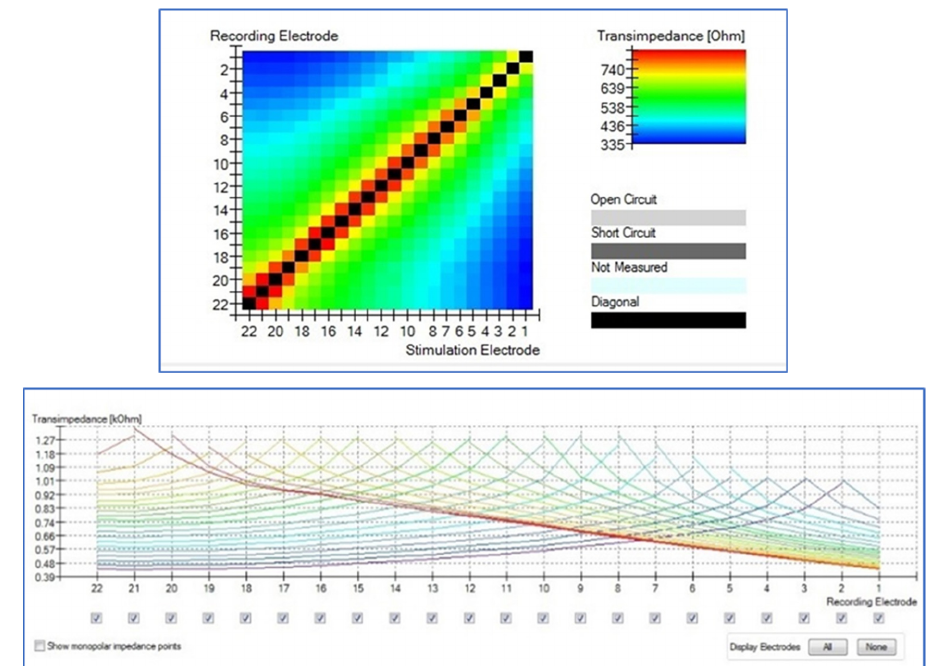
Figure 4. Volume under TIM result comparison chart between CI632 and CI622 recipients.